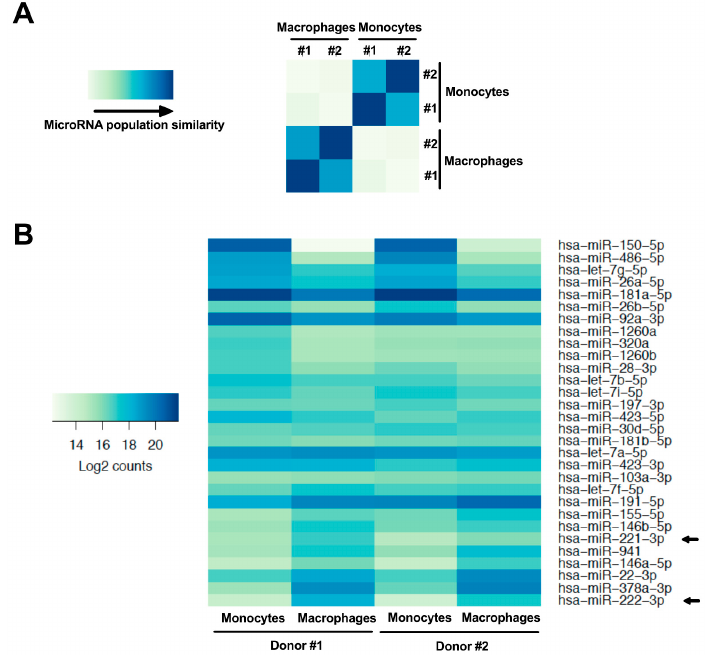
Figure 2. MicroRNA expression is modulated following monocyte differentiation into macrophages. ( A ) Heat map comparing the relative expression of monocyte and macrophage microRNAs in cells derived from the PBMCs of 2 different donors (#1 and #2), as obtained by microRNAseq (the blue gradient represents the level of similarity between two populations; the darkest blue representing equivalent populations). ( B ) Heat map showing the relative expression (darkest blue representing strongest expression; log2[macrophage mean read counts/monocyte mean read counts]) in both cell types of the 30 most highly expressed microRNAs in monocytes or macrophages. Arrows identify miR-221 and miR-222.